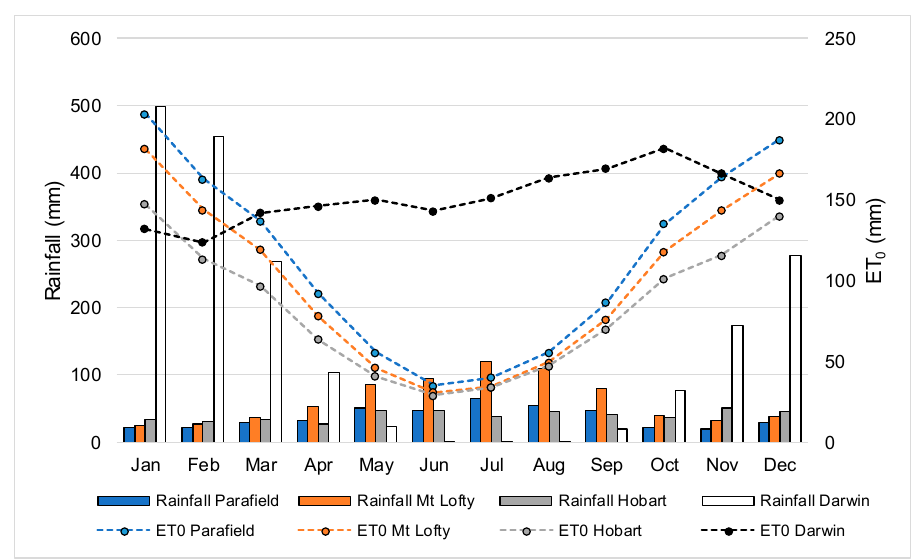
Figure 4. Mean monthly rainfall and reference evapotranspiration (ET 0 ) for each climate scenario,